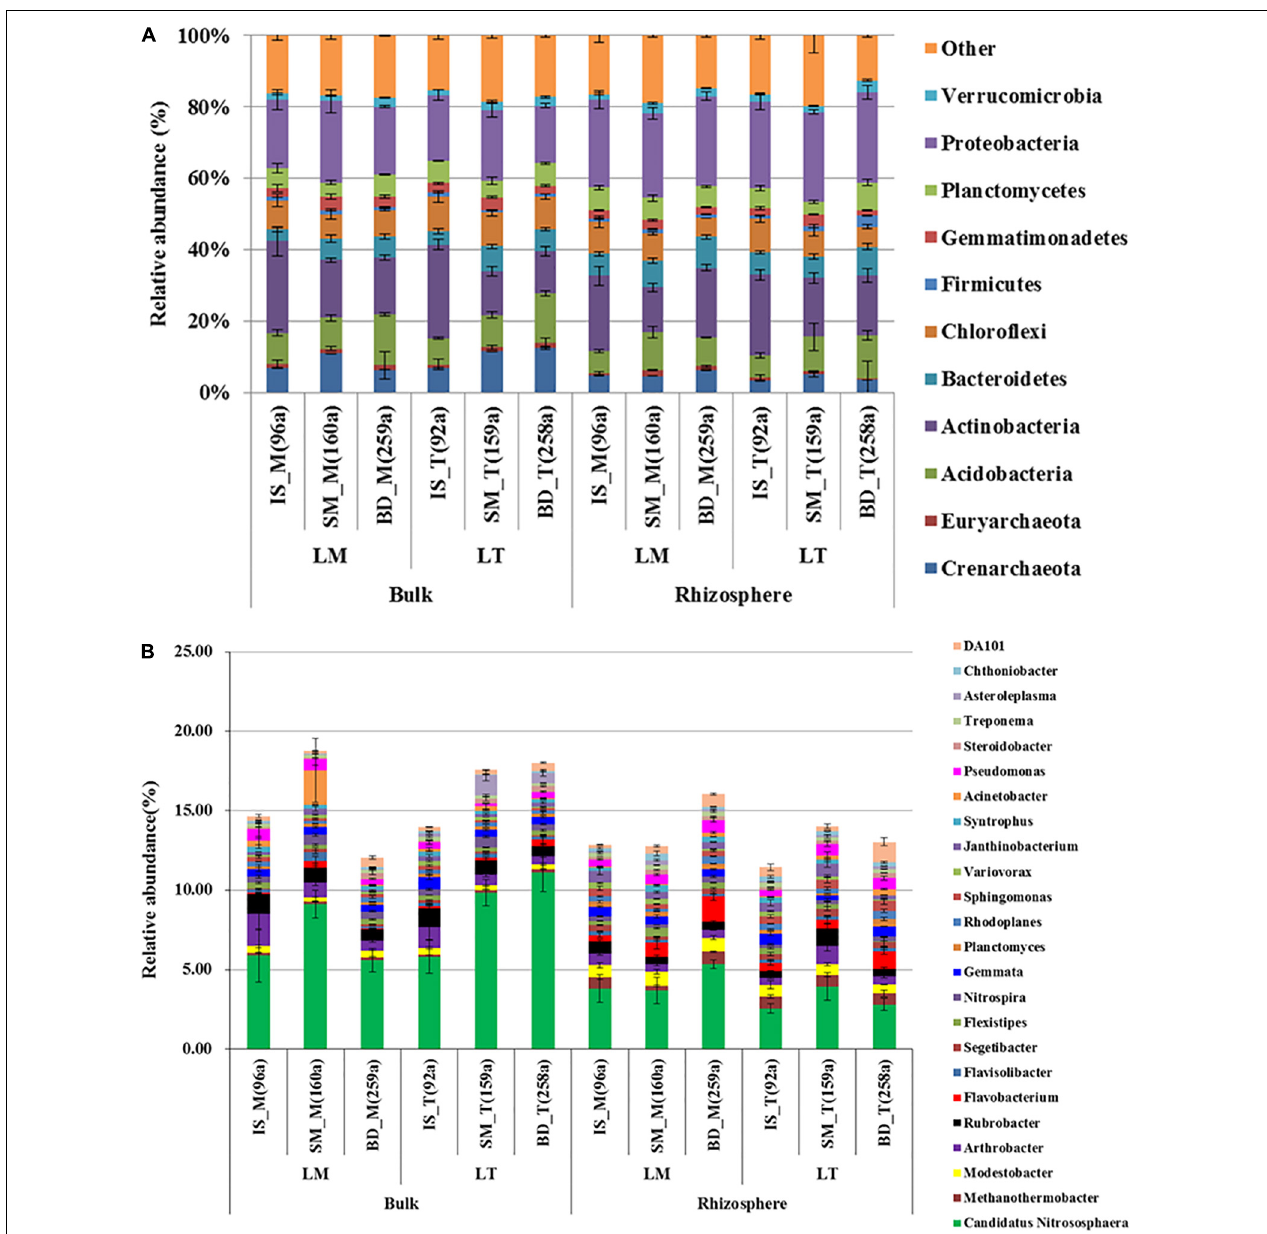
FIGURE 2 | The relative abundance of prokaryotic phyla (A) and genera ( B ). Sites: IS, middle of glacier terminal and small Qiangyong lake; SM, midway along the edge of the smaller lake; BD, approximately one-third of the way along the edge of the larger lake; M and T, the sampling lines, Middle and Top, respectively; S and R, bulk and rhizosphere soils, respectively. The relative abundances are given as a percentage of each phylum or genus against the total 16S rRNA gene sequences. Only phyla with average relative abundance > 1% are shown. Only genera with average relative abundance > 0.18% are shown. Data are shown as average ± SE ( n =